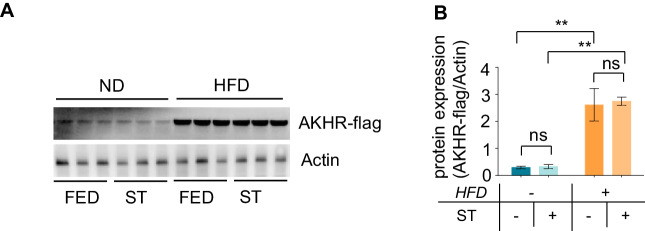
HFD increases neuronal AKHR protein accumulation in both fed and starved conditions.(A-B) AKHR-flag knock-in flies were fed with ND or HFD for 5 d, and then starved for 18 hr or not. AKHR-flag protein level in the head tissue was analyzed by western blot (A, n = 3 biological replicates, each containing 25 flies), and the quantification was shown in (B). *p < 0.05. Student’s t-test was used for pair-wise comparisons.